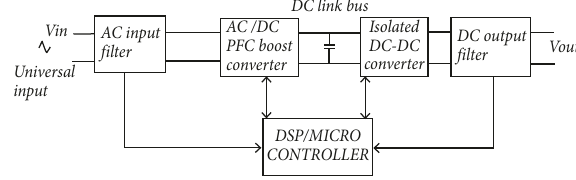
Figure 1: Block diagram of the battery charger